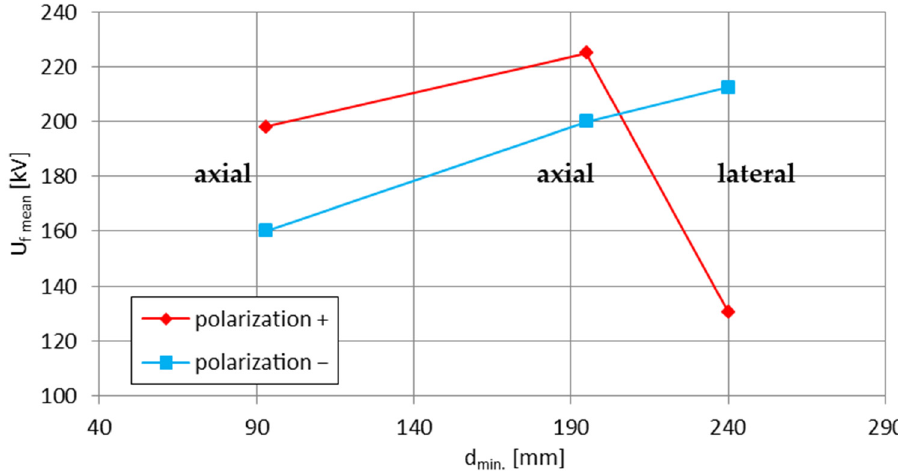
Figure 13. Collected mean flashover voltages over the flight train model for different polarizations, different electrode configurations, and varying total air gap distances.